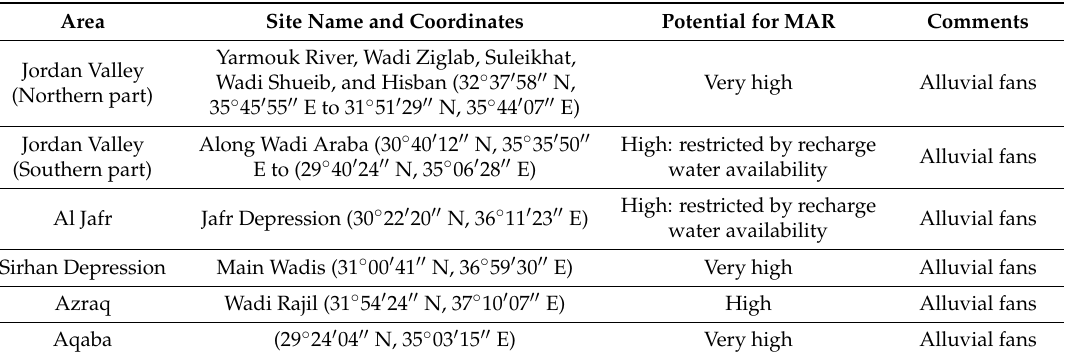
Table 3. Areas and Wadis to be considered for